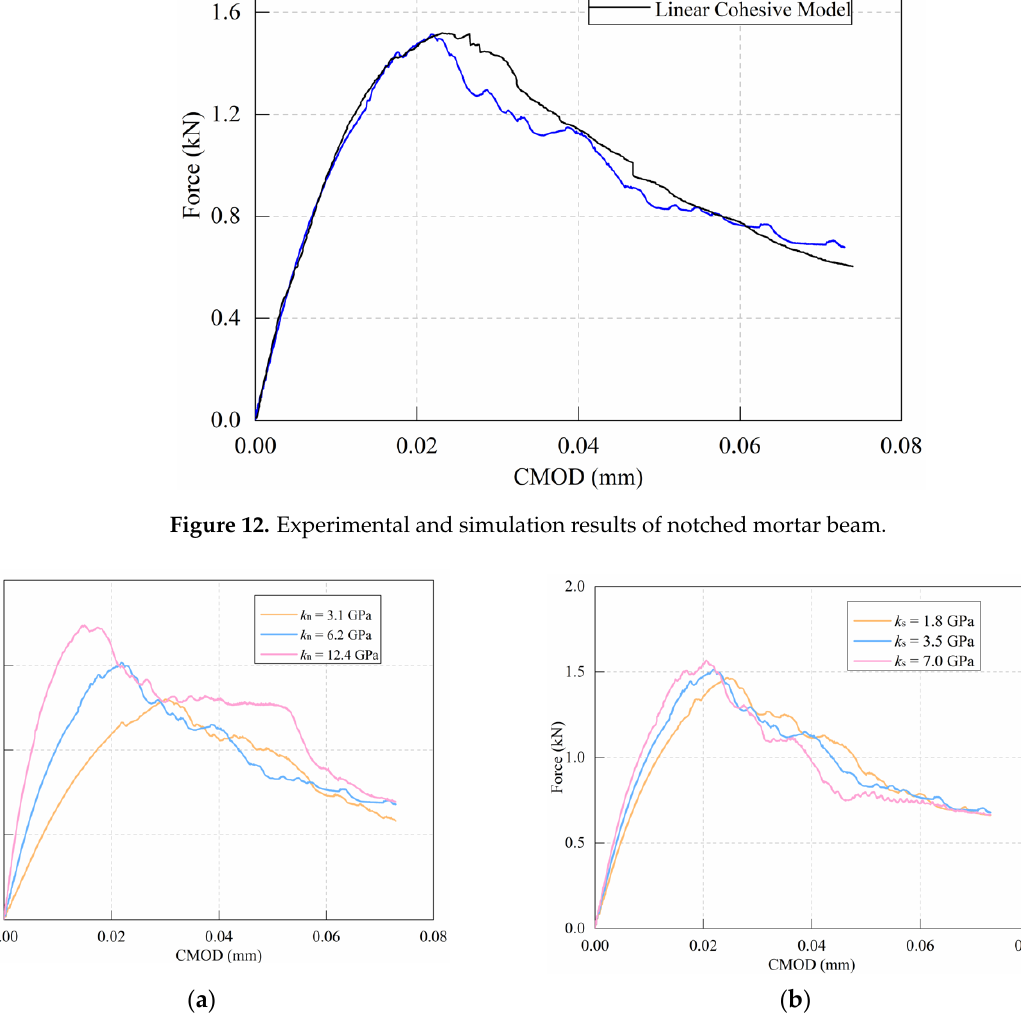
Figure 13. Effect of stiffness: ( a ) normal stiffness; ( b ) shear stiffness.